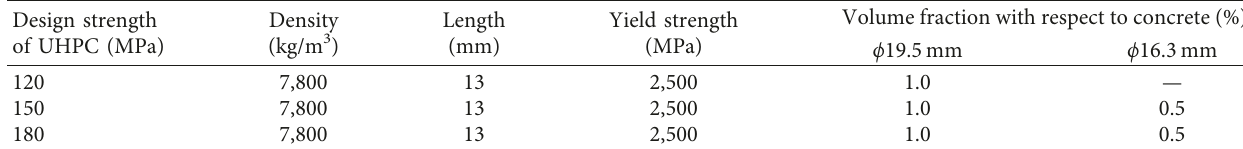
Table 1: Physical properties of steel fiber per UHPC